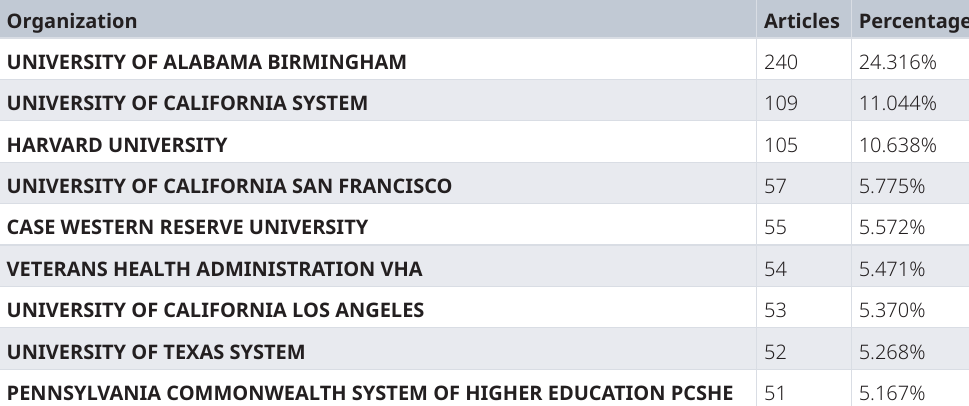
Table 3. The top affiliations in terms of open data publications using Biologic Specimen and Data Repository Information Coordinating Center (BioLINCC) open data. Organization